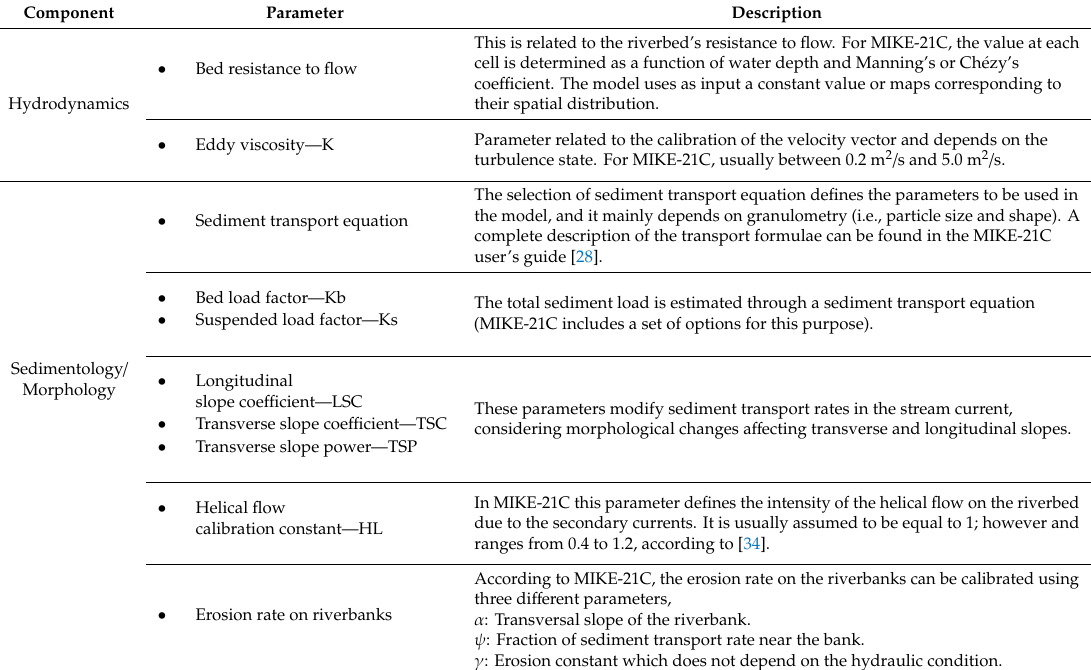
Table 1. Typical calibration parameters. (Source: Adapted from